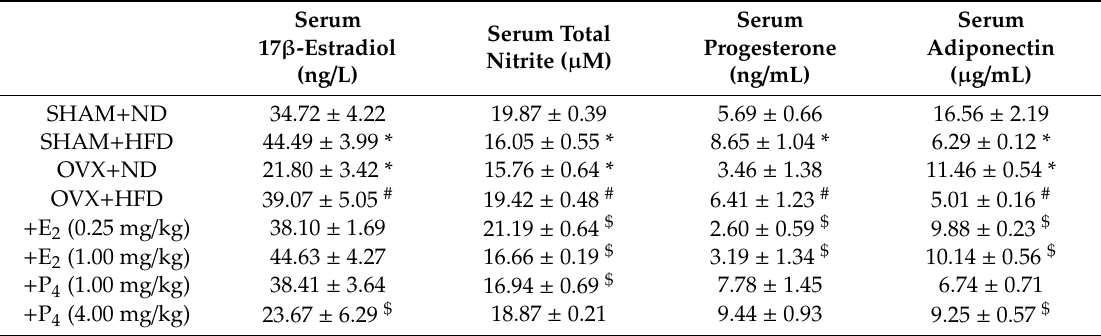
Table 2. Concentrations of serum 17 β -Estradiol (E 2 ), Progesterone (P 4 ), total nitrite, and adiponectin in experimental